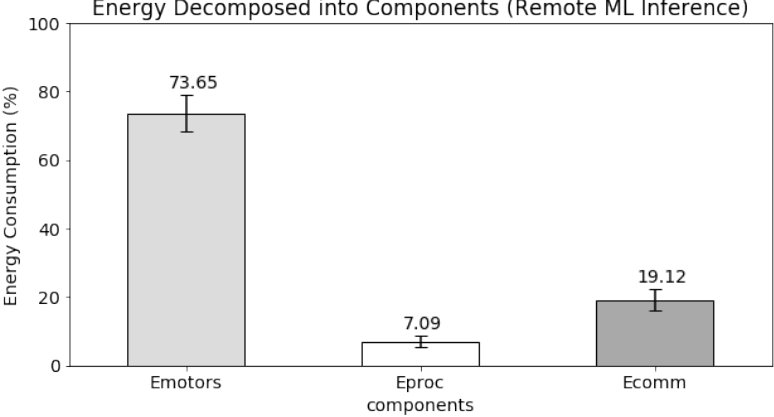
Figure 8. Energy decomposed into its sub-components (Remote ML with